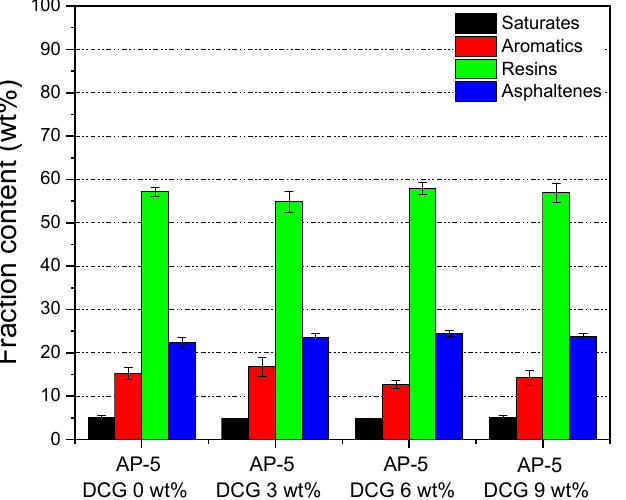
Figure 4. Impact of various dosages of DCG (e.g., 3, 6, 9 wt%) on the SARA generic fractions of base AP-5 asphalt.